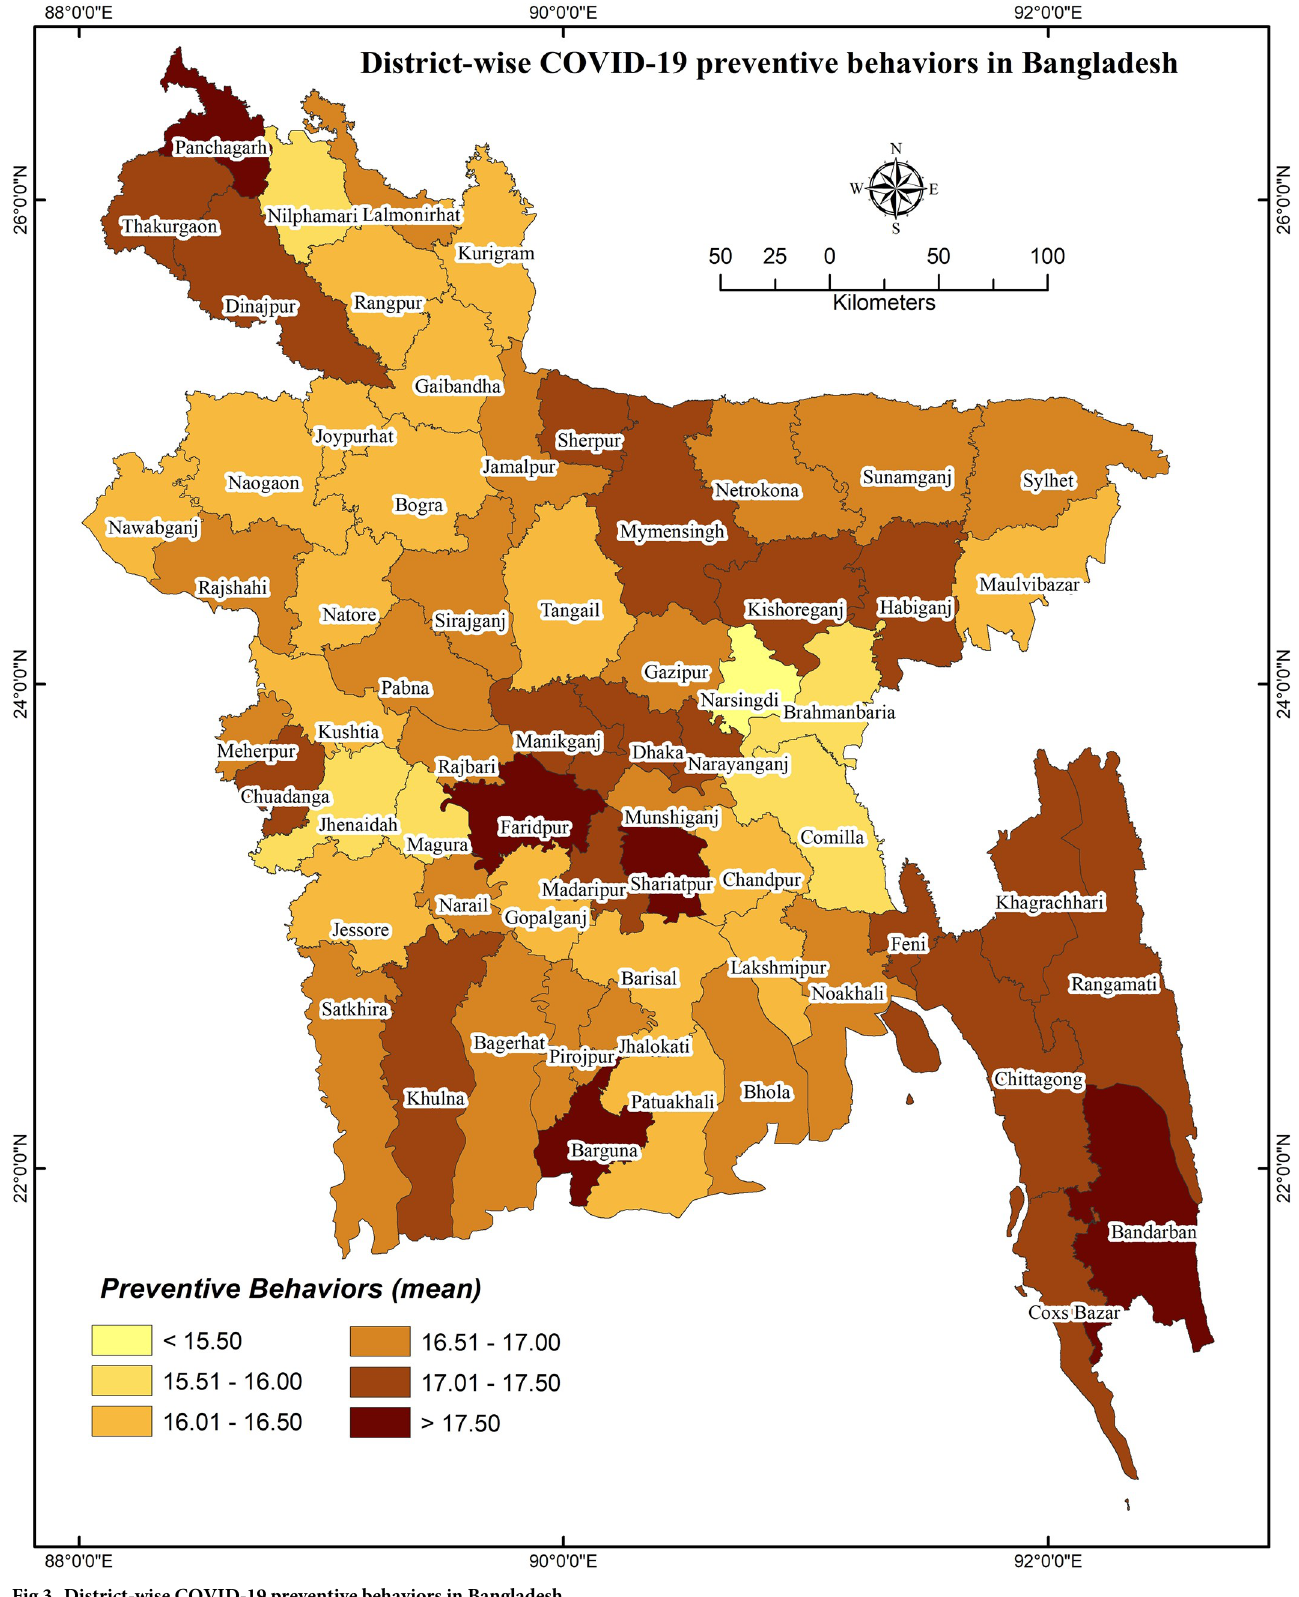
Fig 3. District-wise COVID-19 preventive behaviors in Bangladesh. https://doi.org/10.1371/journal.pone.0251151.g003 PLOS ONE | https://doi.org/10.1371/journal.pone.0251151 May 3,